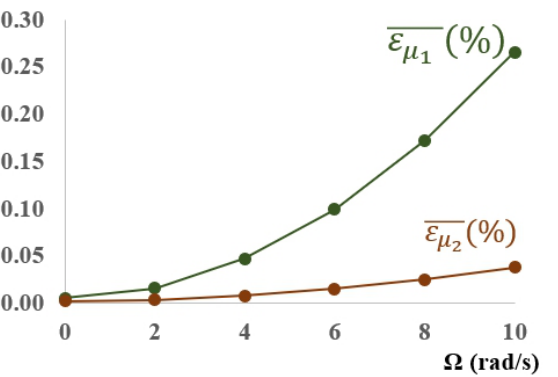
Figure 13. Mean percentage error for each rotation velocity for µ 1 and µ 2